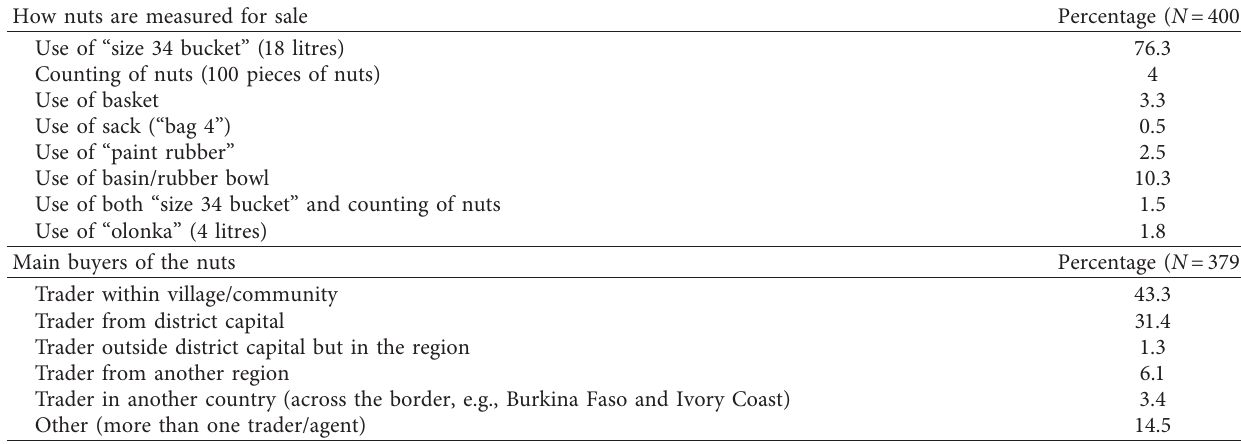
Table 13: Marketing of kola nuts in Ghana.